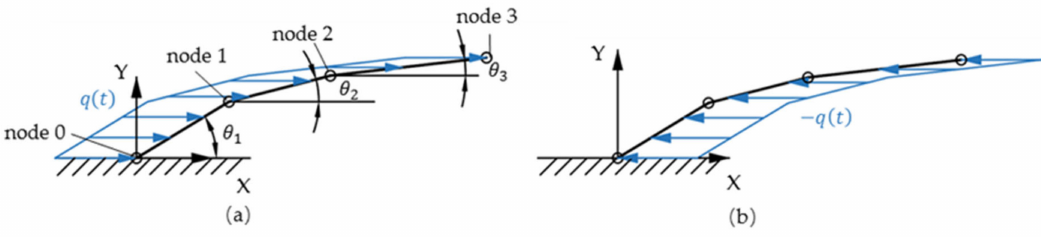
Figure A1. The simplified model of the valve. ( a ) The forward force model; ( b ) the reverse force model.